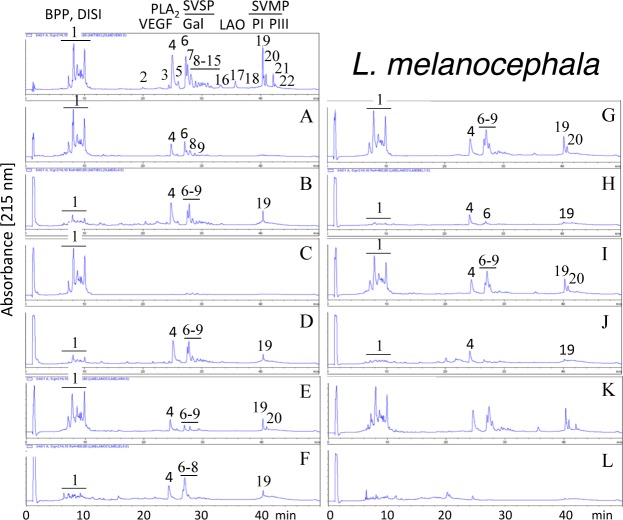
Immunoaffinity chromatography-based antivenomic analysis of the immunoreactivity of polyspecific and monospecific antivenoms towards the venom of L. melanocephala from Costa Rica.Panels display reverse-phase separations of whole venom components, and non-retained (A, C, E, G, and I) and the retained (B, D, F, H, and J) fractions recovered, respectively, from the affinity columns of immobilized BCL, BL, AL, AB, and AC antivenoms. Panels K and L, non-retained and retained venom fractions by immobilized equine control immunoglobulins. Protein acronyms as in the legend of Fig 2.